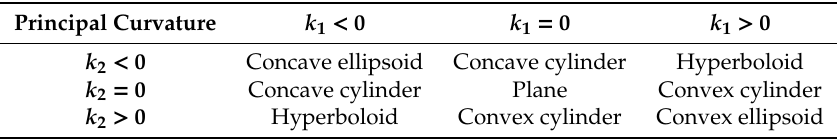
Figure 2. Schematic diagram of the normal plane of the principal curvature at a point on the surface. Source: Wikipedia. Table 1. Classification of surface types.